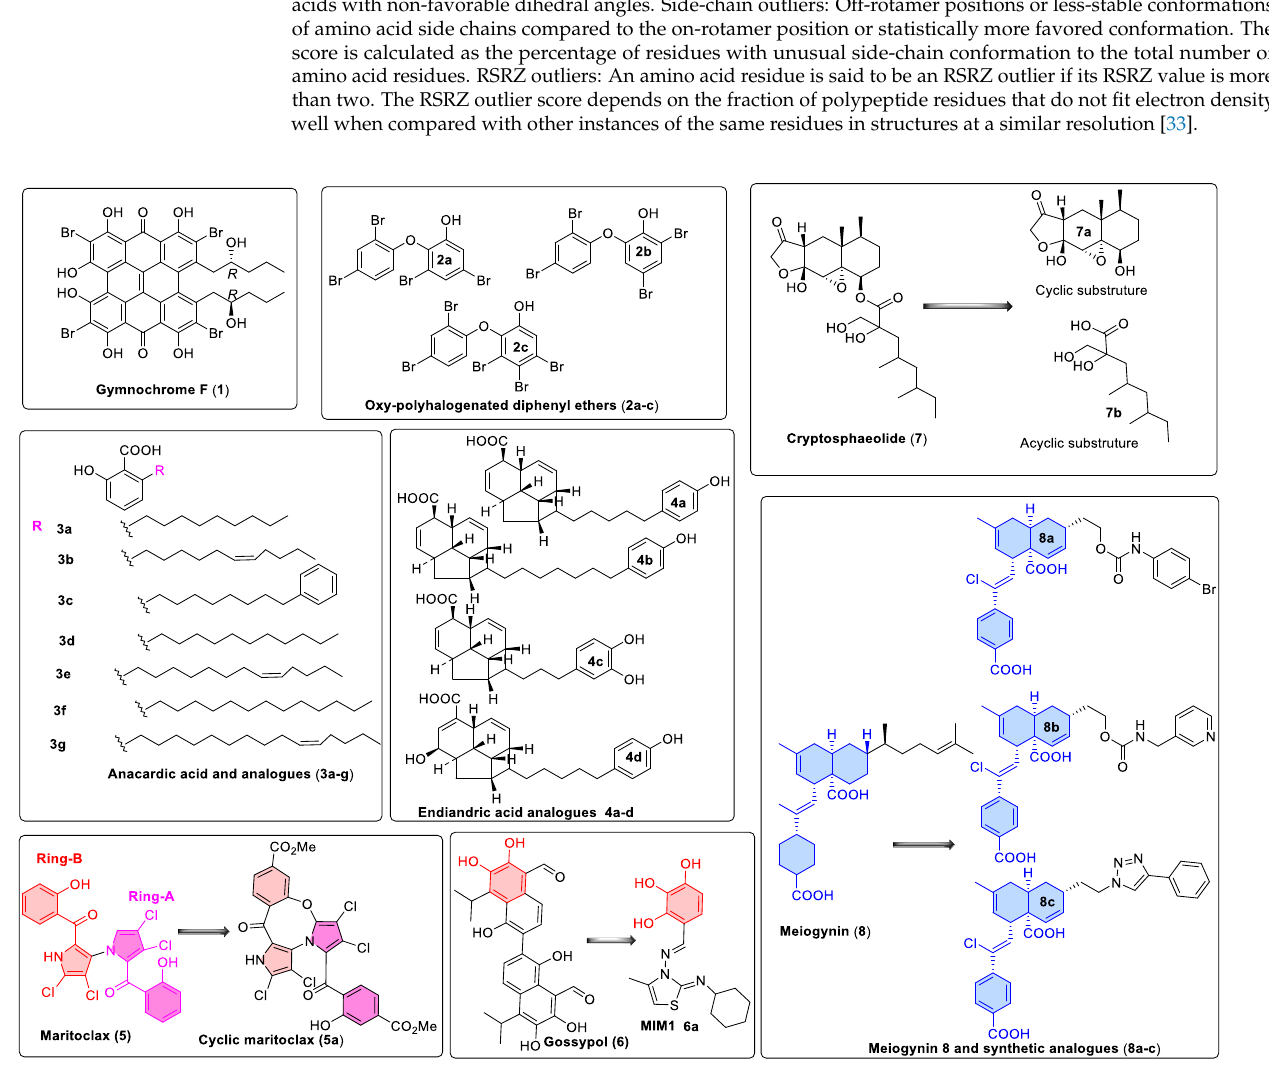
Figure 2. Natural product and derivatives identified as hMcl-1 inhibitors: 1. Gymnochrome-F, a phenanthroperylenequinone-containing core compound isolated from a deep-water Crinoid, Halopus rangii [19]. 2. Oxy-polyhalogenated diphenyl ethers from a sponge Dysidea (Lamellodysidea) herbacea [20]. 3. Anacardic acids from Knema hookeriana [21]. 4. Endiandric acids analogues from Beilschmiedia ferruginea [22]. 5. Maritoclax , obtained from Actinomycete strain CNQ-418, which shares 98.1% 16S rRNA gene sequence identity with Streptomyces sannurensis, suggesting that it may be a new Streptomyces species [23,24], and its synthetic analog, the maritoclax structure, can be divided into ring-A (magenta) and ring-B (red) for easy presentation. 6. Gossypol [25,26] and hMcl- 1 inhibitor molecule 1 (MIM1) [27], a high-throughput screening compound, is not a natural product but shares features with Gossypol. 7. Cryptosphaerolide from a marine-derived ascomycete related to the genus Cryptosphaeria [28] and derivatives. 8. Meiogynin (obtained from ethyl acetate extract of the bark of Meiogyne cylindrocarpa ) and synthetic derivatives ( 8a – c ) [29,30].